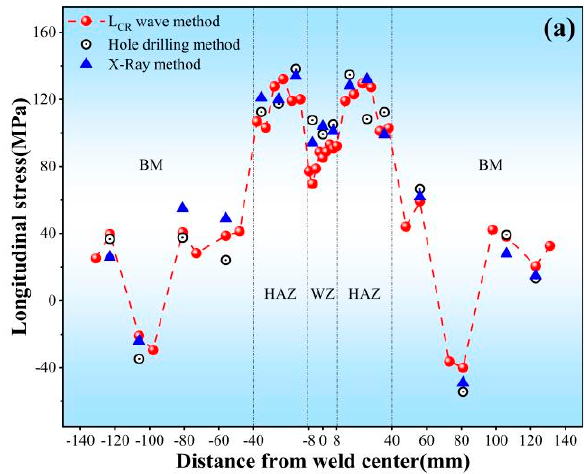
Figure 6. Testing schematic of different methods.